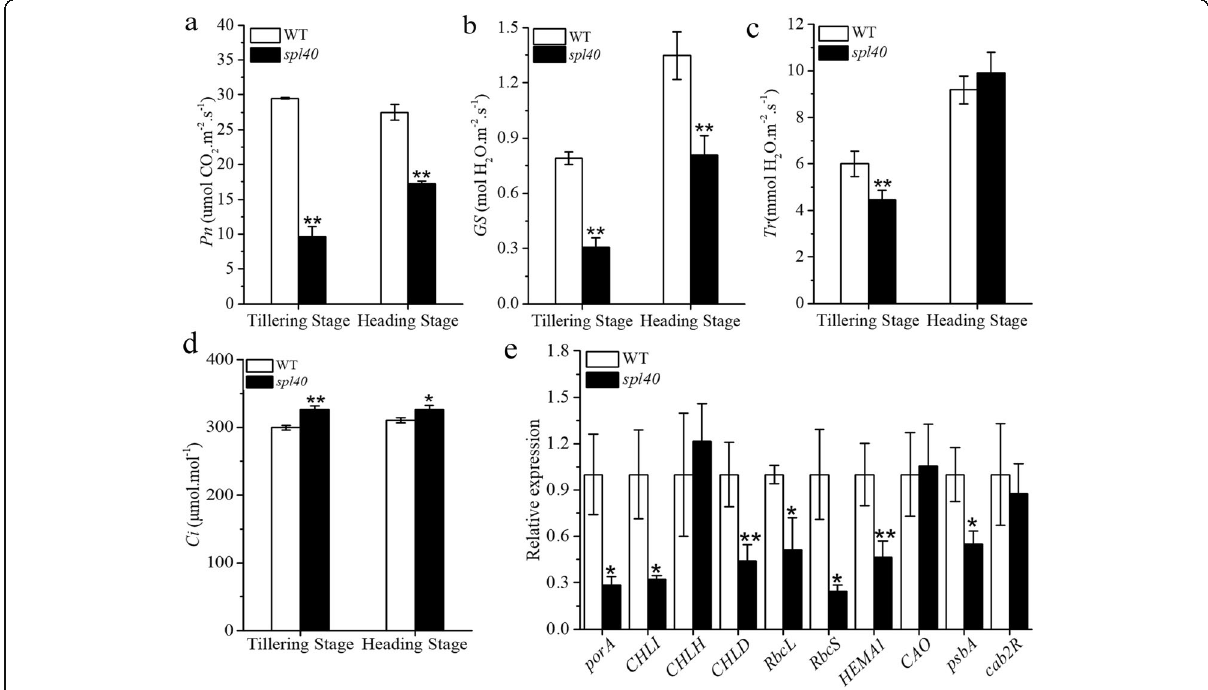
Fig. 2 Photosynthesis parameters of leaves at the tillering and heading stages. a Net photosynthetic rate ( Pn ). b Stomatal conductance ( Gs ). c Transpiration rate ( Tr ). d Intercellular CO 2 concentration ( Ci ). e Expression profile of photosynthesis related genes in spl40 and WT at tillering stage. Values are means ± SD ( n = 3); ** indicates significance at P ≤ 0.01 and * indicates significance at P ≤ 0.05 by Student ’ s t